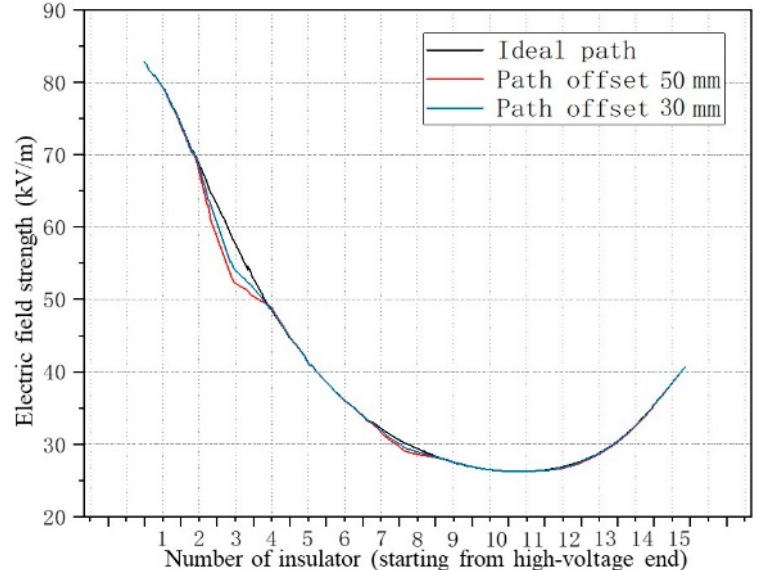
Figure 6. Schematic diagram of detecting attitude disturbances of equipment. According to the simulation curve, the detection distance is 300 mm. In the case of path joggle at the high-voltage end, the space electric field of the insulator string changes the most.